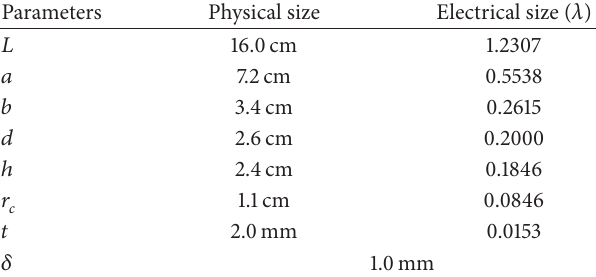
Table 1: The optimal parametric values of the proposed